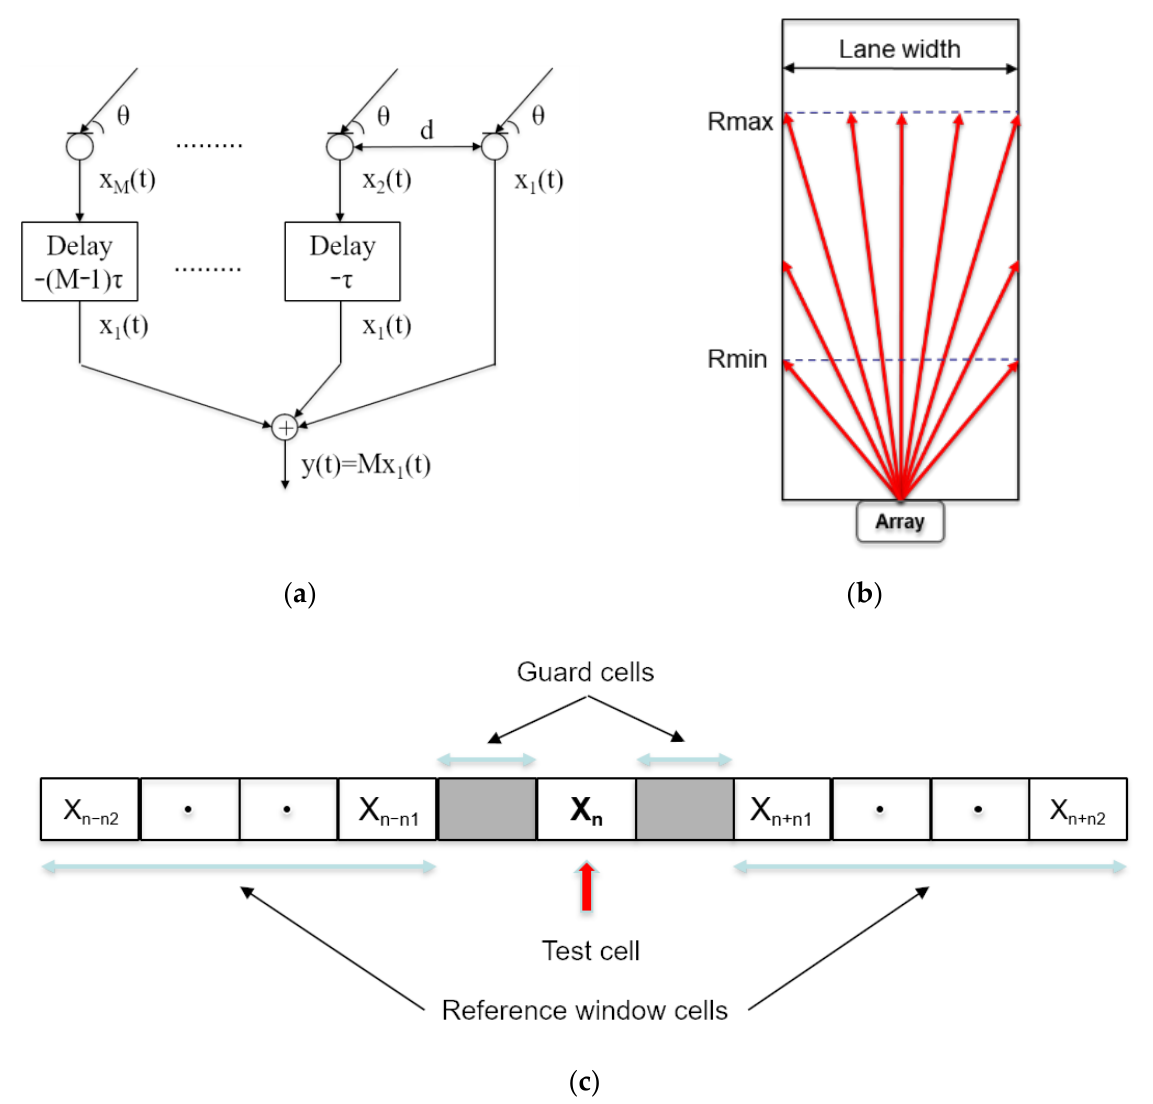
Figure 4. ( a ) Delay and Sum beamformer. ( b ) Lane window. ( c ) CFAR detector. The Detection block implements three processes: